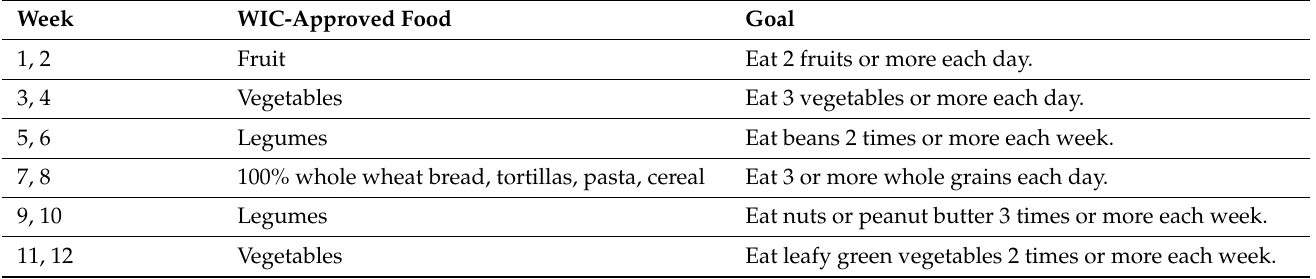
Table 1. Healthy Roots behavior change